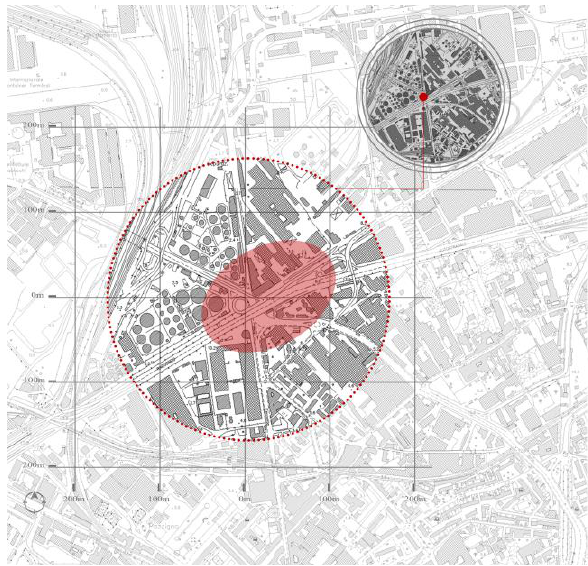
Figure 2 . East Naples. Detail of the urban intersection subject to experimentation.